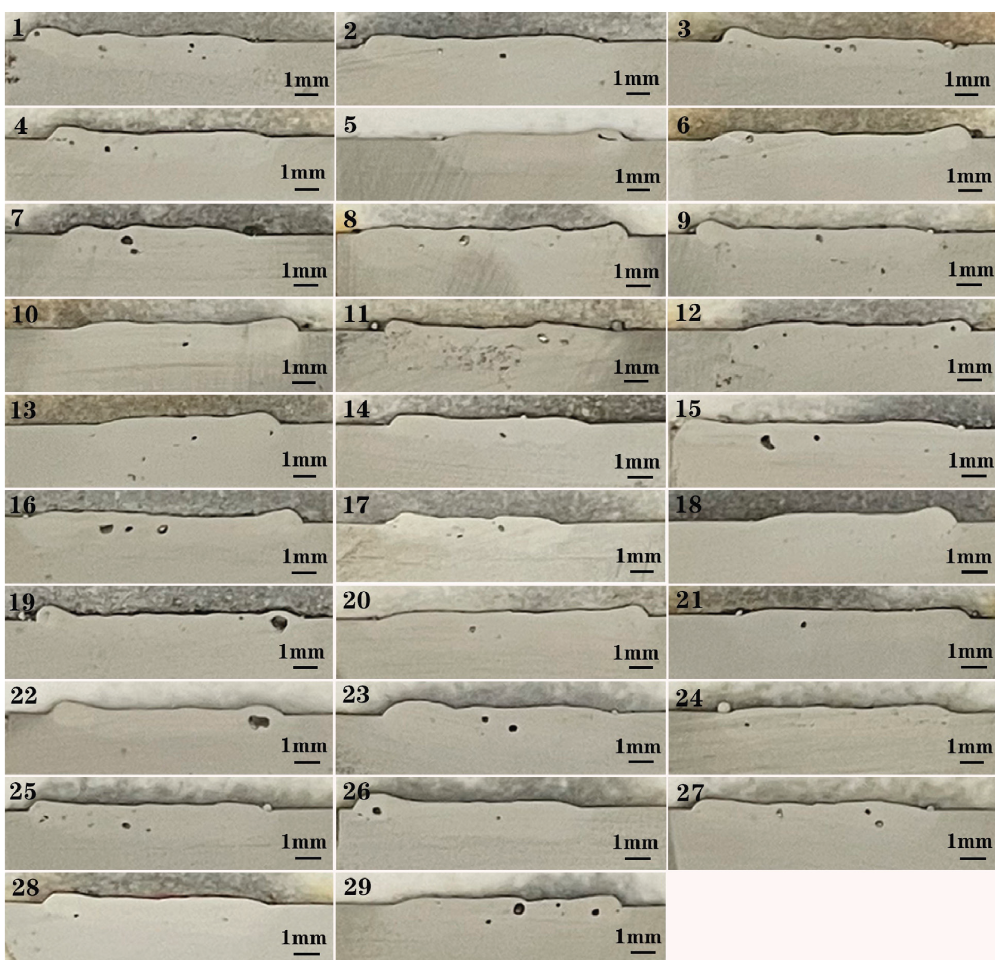
Figure 2: Cross-sectional morphology of the cladding layer.